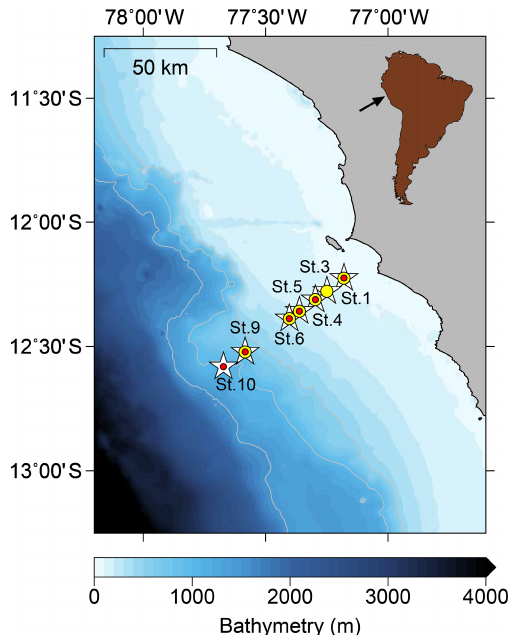
Figure 1. Sampling stations on the Peruvian continental margin during cruises M136 and M137 along a latitudinal depth transect at 12 ◦ S. The sampling stations for pore waters are depicted by white stars, bottom waters are shown using yellow dots, and ben- thic chamber incubations are denoted by red